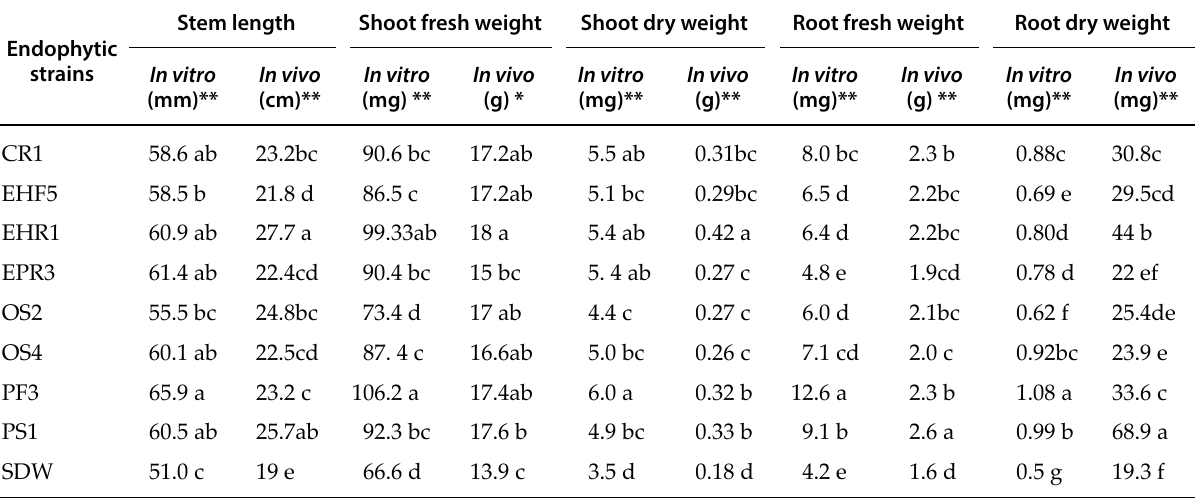
Table 5. Mean parameters of tomato plants treated with different endophytic bacterial strains. Stem Endophytic strains